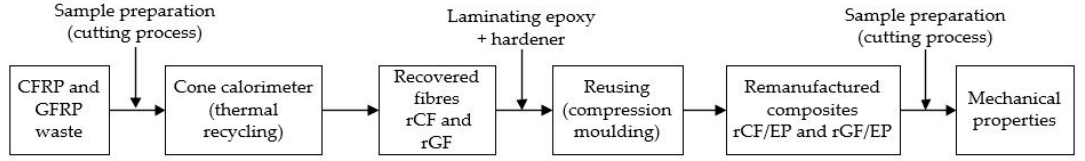
Figure 2. Schematic overview of this study. Abbreviations: CFRP = carbon fibre-reinforced polymer;